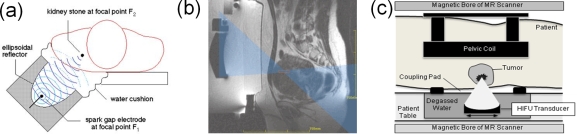
(a) Schematic of the principle of ESWL. (b) Image of human body with symptomatic fibroids. Sonication pathway is superimposed on the image and the spot where irreversible thermal damage is expected is also superimposed onto this image. Adapted from [230] with permission. (c) Schematic of a magnetic resonance guided HIFU equipment for the possible treatment of tumor tissue. Figure adapted from [231] with permission.